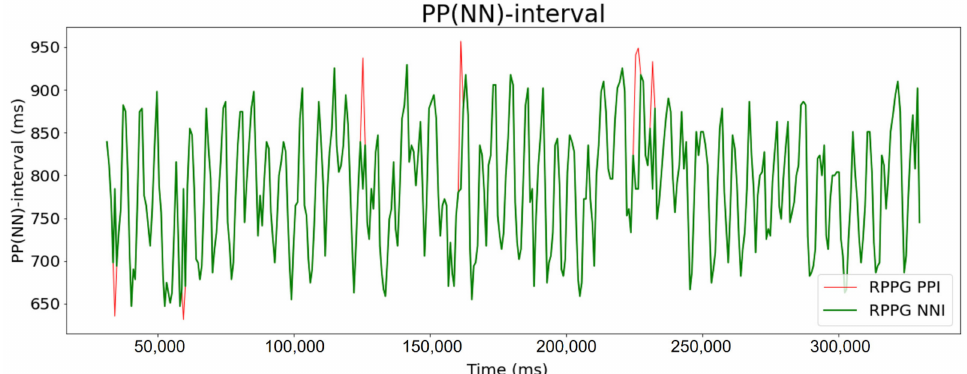
Figure 2. Policy for splitting 11-minute BVP data into eleven 300-second pieces of data.